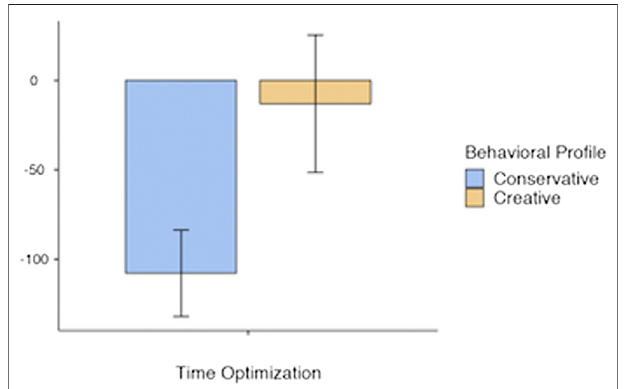
FIGURE 3 | Mean average score of time optimization considering participants ’ behavior pro fi les.